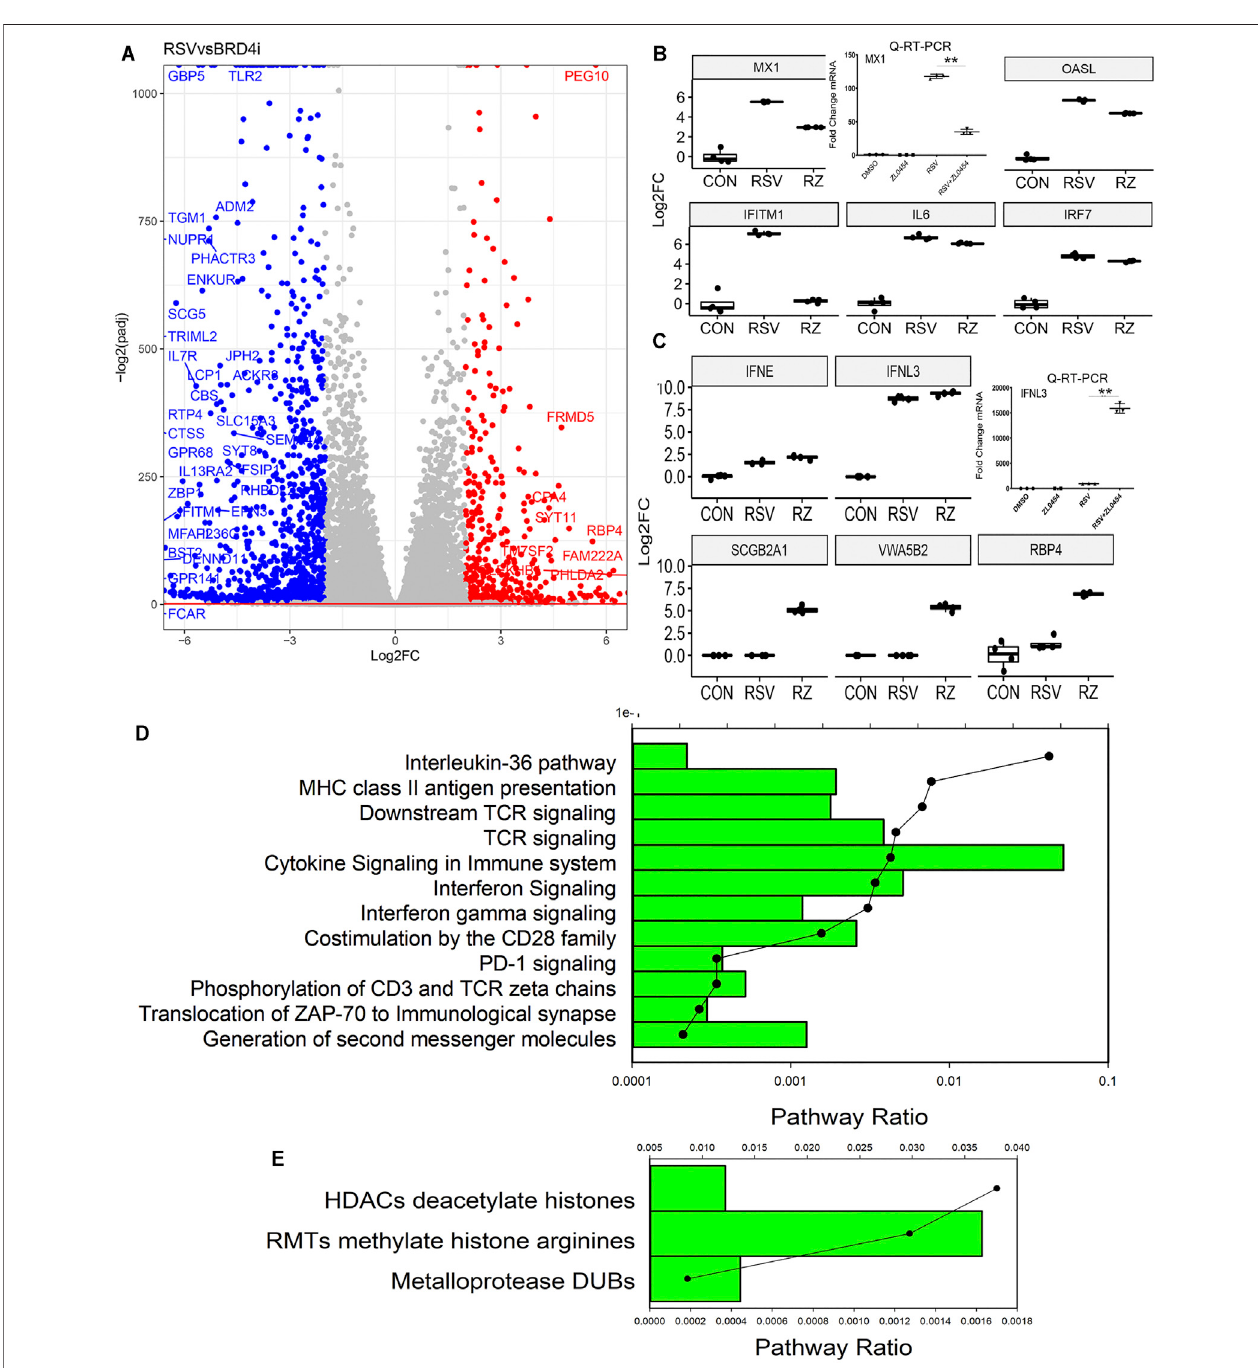
FIGURE 4 | BRD4-dependent gene network. (A) Volcano plot of BRD4-dependent genes comparing RSV vs RSV + BRD4 inhibitor – treated cells. Genes downregulated by BRD4 inhibitor are plotted in blue and those upregulated by BRD4 inhibitor are shown in red. (B) RSV-inducible interferon stimulatory genes dependent on BRD4. First graph is RNA-Seq data (log 2 FC) for the MX1 gene. Adjusted pValue for RSV vs RSV + ZL0454 (cid:1) 1.12E-15. Right graph is qRT-PCR of an independent experiment. MX1 expression is shown as fold change over mock-infected controls. **, p < 0.01 by post hoc Tukey ’ s comparison test. Remainder of graphsareRNA-Seqlog 2 FCpresentedas25-75%interquartilegraphs.Adjusted p valuesforRSV vs RSV+ZL0454contrastare IFITM1 (cid:1) 7.64E-47, OASL (cid:1) 7.97E-34; and IRF7 (cid:1) 0.00038. (C) RSV-inducible genes repressed by BRD4. RNA-Seq of IFNL3 , where ZL0454 increases the RSV-induced expression. Adjusted p value of the RSVvsRSV+ZL0454contrastis (cid:1) 0.0019.Rightgraph,validationof IFNL mRNAexpressionbyindependentqRT-PCR.**, p < 0.001.Adjusted p ValuesforRSV vs RSV + ZL0454 contrast in DESeq2 are as follows: SCGB2A1 (cid:1) 7.48E-7; VWASB2 (cid:1) 1.147E-7; IFNE p (cid:1) 0.00041; and RBP4 (cid:1) 7.73E-38. (D) Genome Ontology (GO) enrichment of BRD4-dependent RSV-upregulated genes. Genes with 4-fold log 2 FC (RSV vs RSV + ZL0454) and adjusted p -value < 0.01 were analyzed for pathway enrichment (reactome.org). For each gene set, the fraction of genes represented in the pathway and the signi fi cance (false discovery rate, FDR) are plotted. Shown are the pathways with FDR < 0.05. (E) GO enrichment of RSV-upregulated genes repressed by BRD4. Genes with < -4-fold change in TPM (RSV vs RSV + ZL0454 ) and adjusted p -value of < 0.01 were analyzed for pathway enrichment as given above